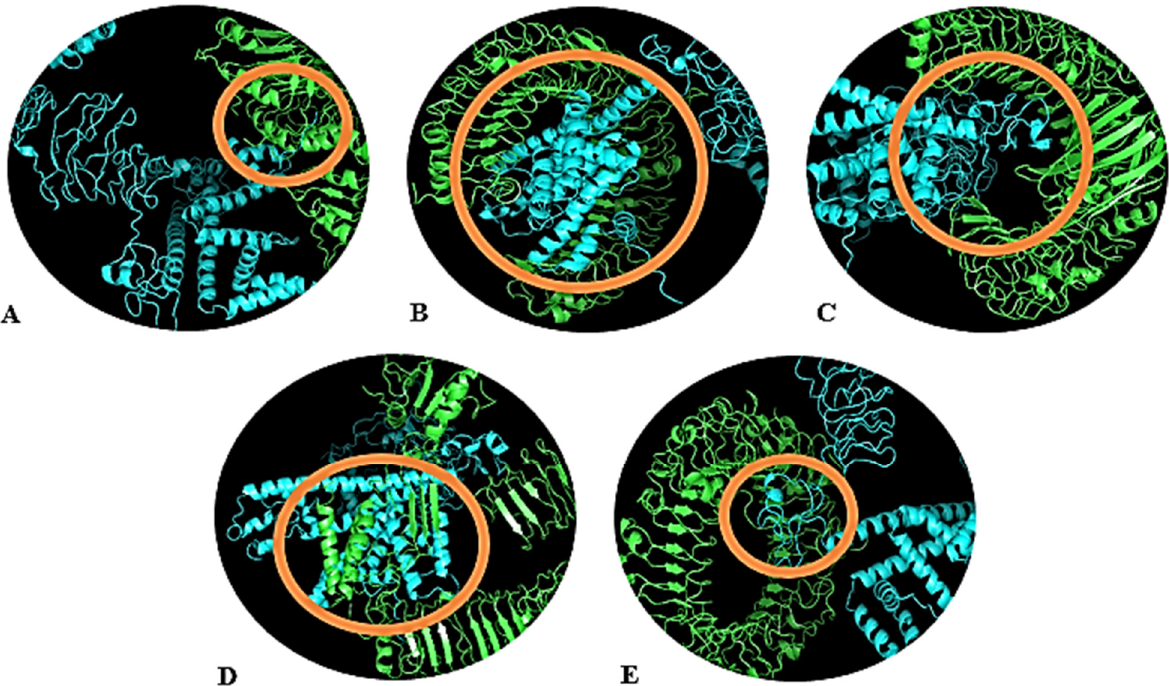
Figure 4. Docked complexes of the vaccine and the TLRs. ( A ) TLR-2, ( B ) TLR-3, ( C ) TLR-4, ( D ) TLR-5, ( E ) TLR-8. The TLRs are shown in green color, whereas the vaccine construct is in blue color. Interacting residues are highlighted with an orange